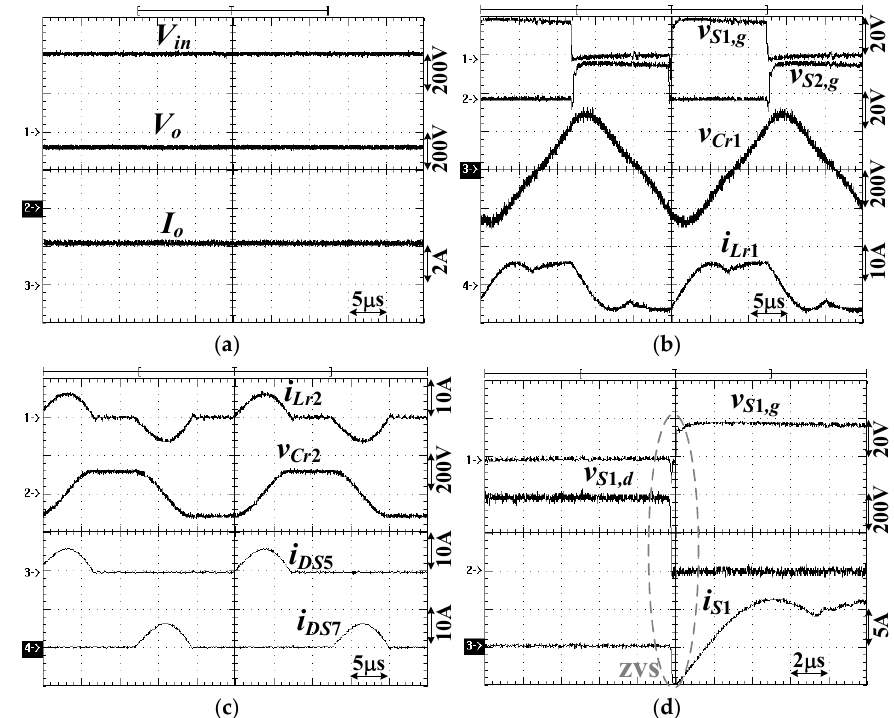
Figure 11. Experimental waveform of the proposed converter at V o = 200 V and the rated load current ( a ) V in , V o , and I o ; ( b ) v S 1, g , v S 2, g , v Cr 1 , and i Lr 1 ; ( c ) v Cr 2 , i Lr 2 , i DS 5 , and i DS 7 ; ( d ) v S 1, g , v S 1, d , and i S 1 . Processes 2021 , 9 , x FOR PEER REVIEW